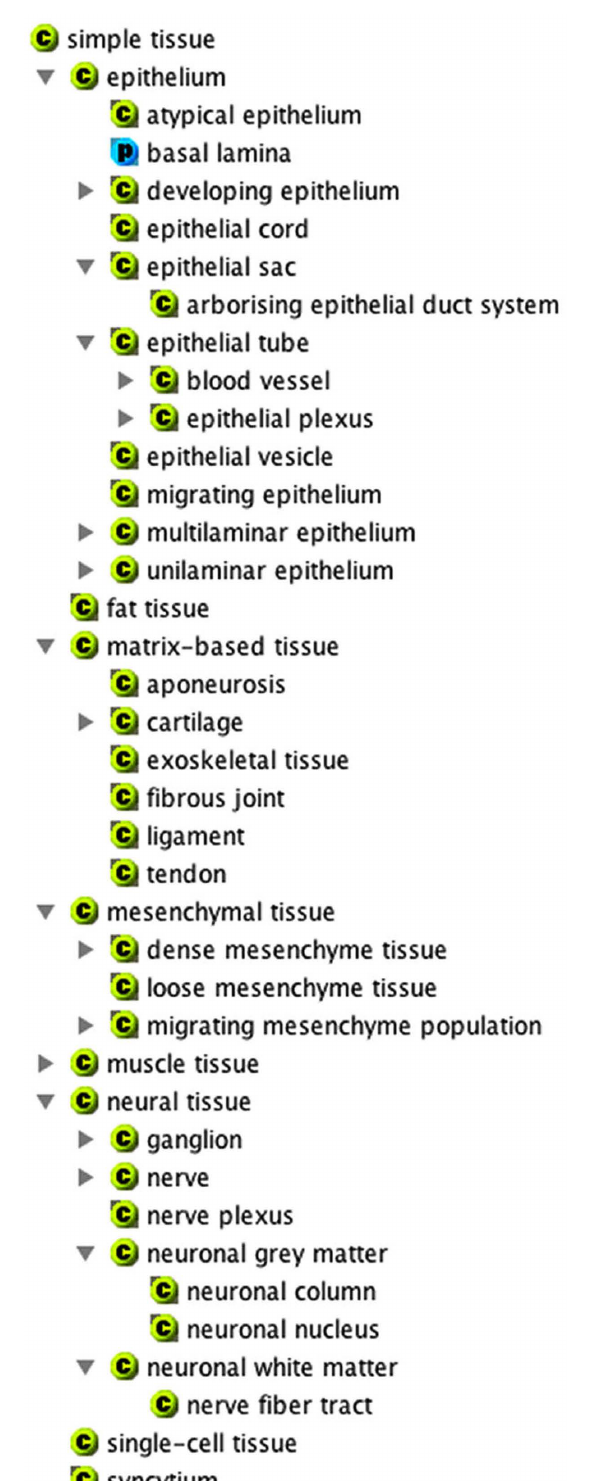
FIGURE 4 |The use of theAEO in classifying the ontology of human developmental anatomy (EHDAA2). The ontology is opened in the OBO-Edit browser to demonstrate (i) those tissues classed ( is_a relationship) within the gender-specific anatomical structure hierarchy (red arrow), and (ii) the head category of organism subdivision with its constituent organ groups ( part_of